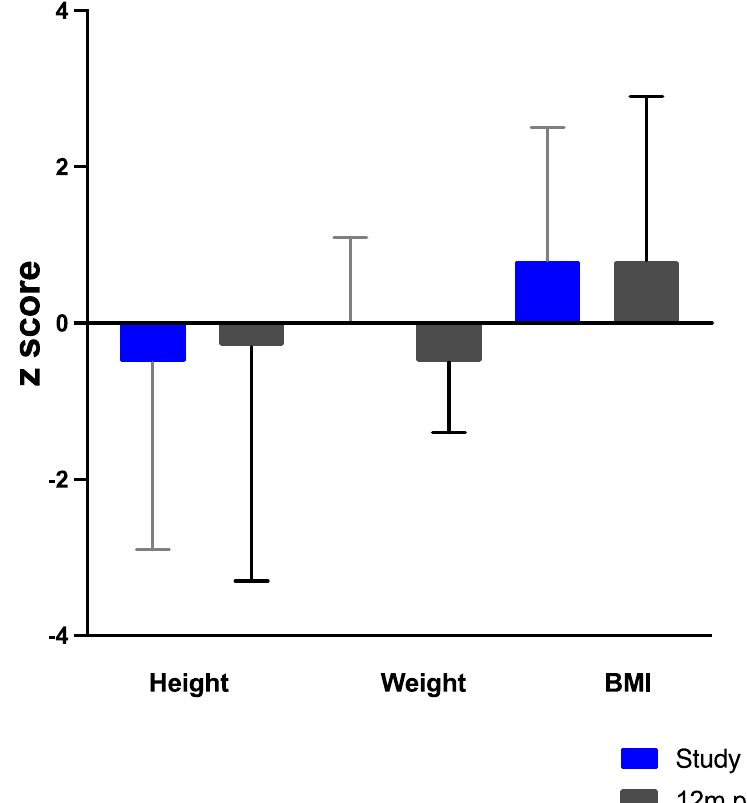
Figure 2. Median height, weight and BMI z-scores for n = 5 children at the start and end of the 12 months of using the study product.